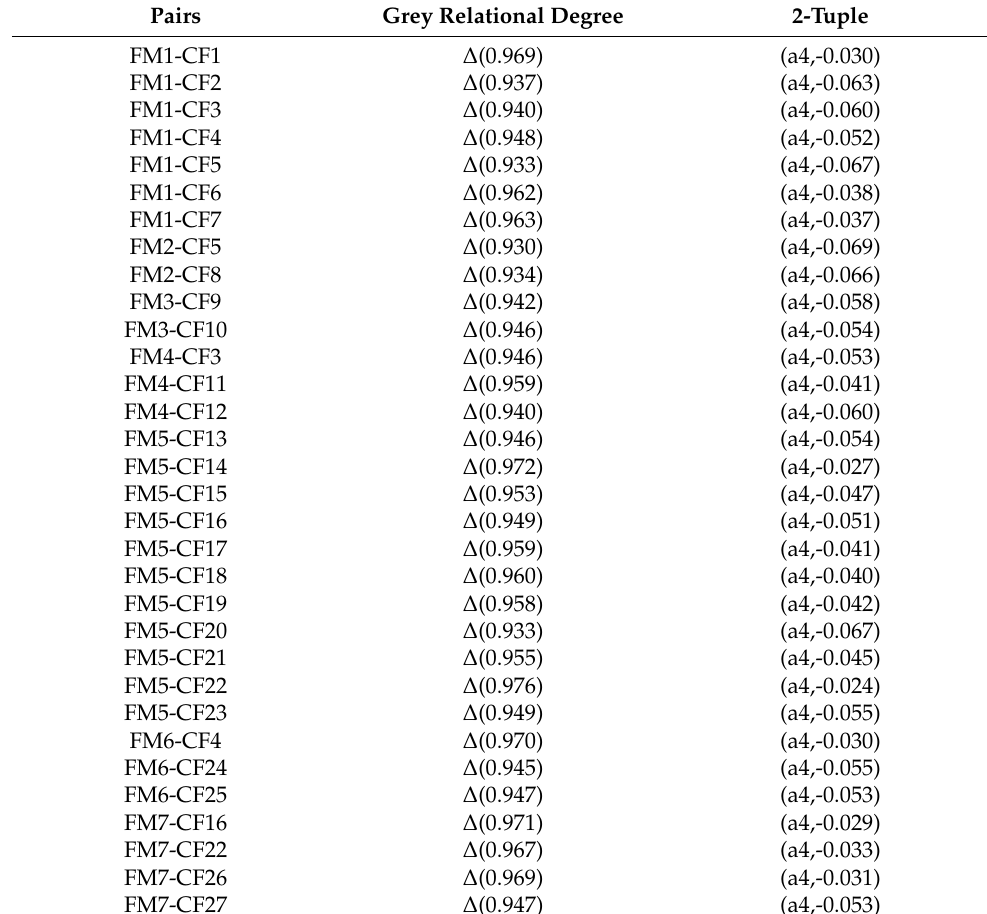
Table 10. The grey relational degree of FM–CF